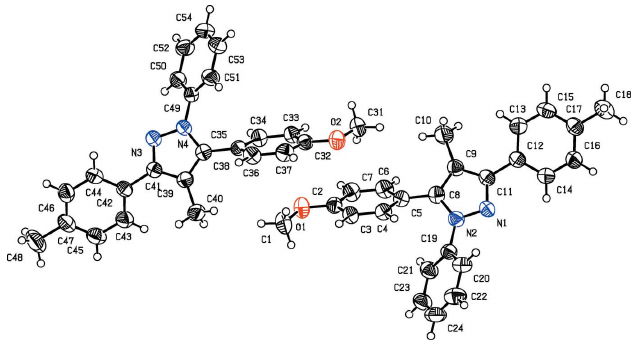
Figure 1 The asymmetric unit of the title compound with the atom-labelling scheme and 30% probability ellipsoids for non-H